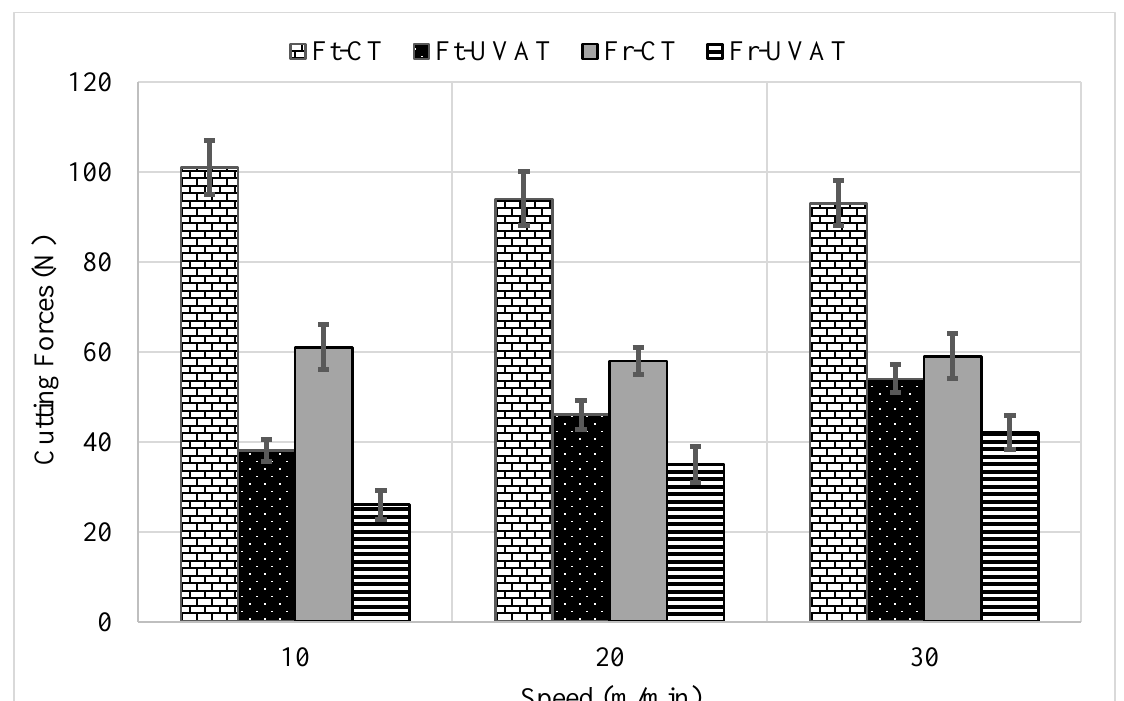
Figure 11. Cutting forces at various DoCs and constant speed of 10 m/min.